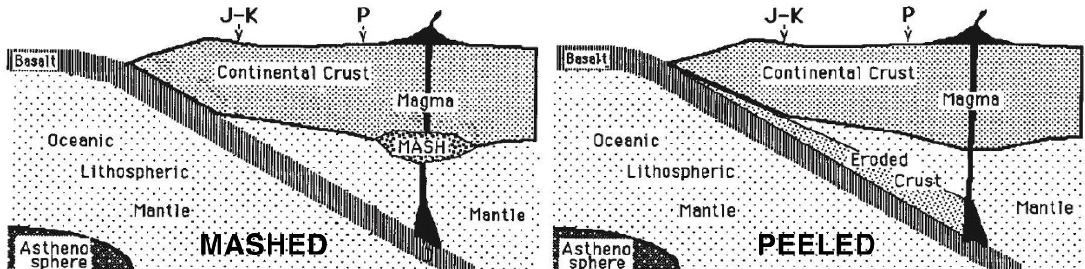
Figure 1. Two alternative explanations, as originally illustrated by Hickey-Vargas in 1991 [1], for the incorporation of continental crust into Andean magmas. MASHED on the left involves Mixing, Assimilation, Storage and Homogenization in a MASH zone located at either the lower crust/mantle boundary or within the crust [2]. PEELED, on the right, involves recycling of subduction eroded crust into the mantle wedge source [3–5]. J–K and P indicate the position of the Jurassic-Cretaceous and Pliocene plutonic belts, respectively, in the Andes of northern Chile. The recently active volcanic arc is ~250 km east of the Jurassic arc as a result in part of subduction erosion [6]. (Reprinted from Nature, volume 350, Hickey-Vargas, R. Peeled or MASHed?, page 350, Copyright 1991, with permission from Springer Nature.).